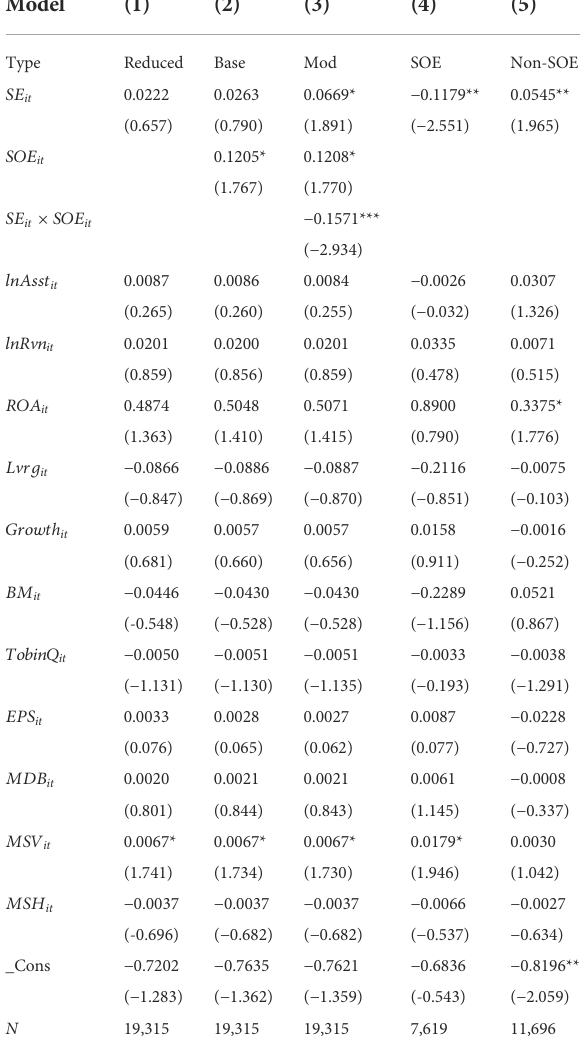
TABLE 4 Results of baseline